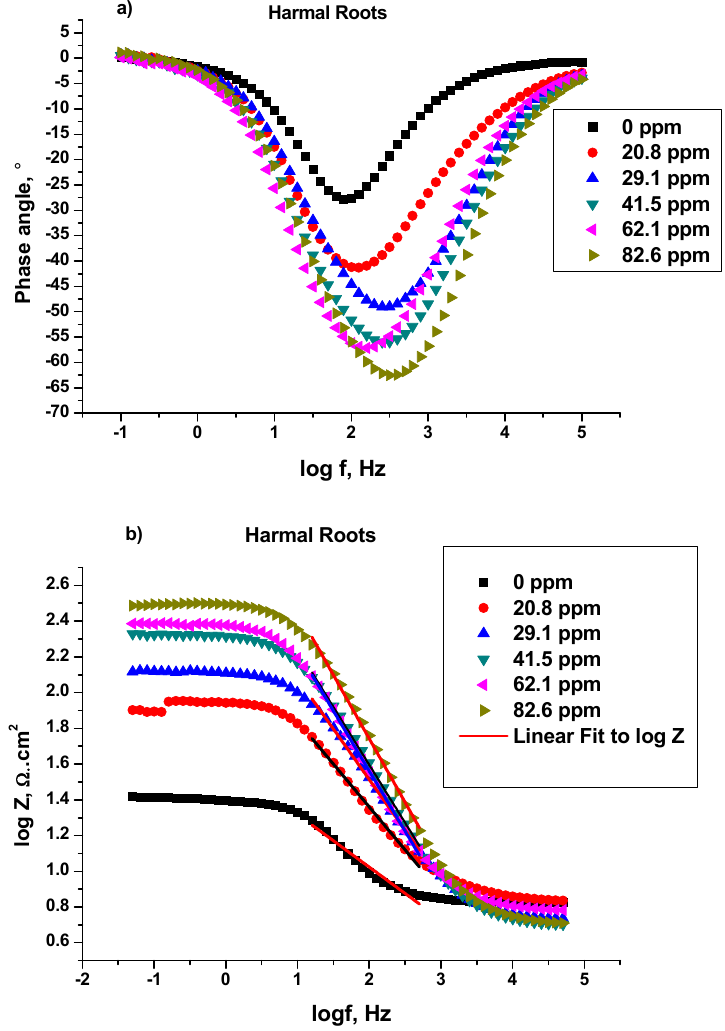
Figure 6. Bode phase ( a ) and Bode ( b ) plots of a C-steel electrode in 0.25 M H 2 SO 4 solution with and without different concentrations of Harmal roots extract.